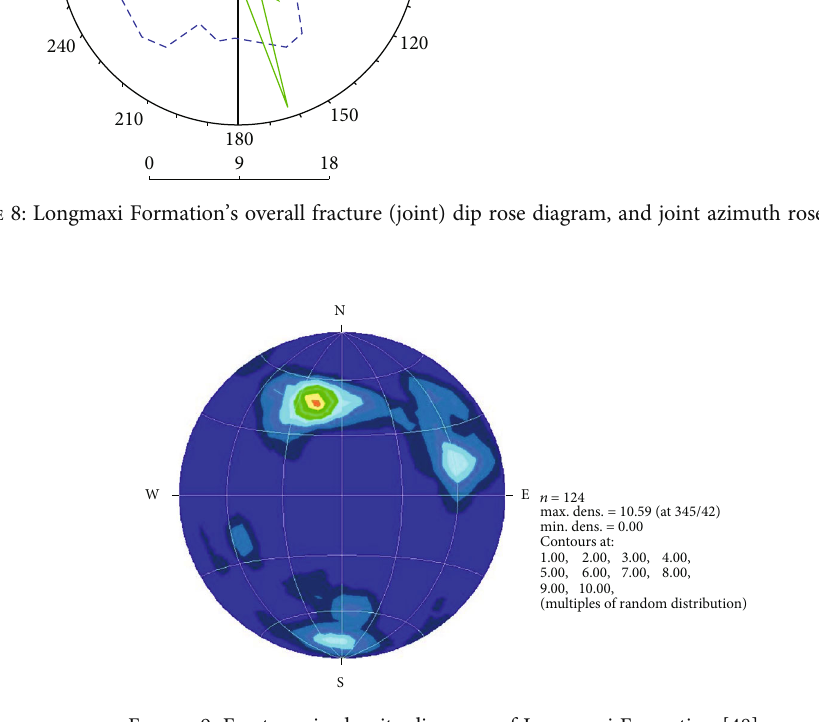
Figure 9: Fractures isodensity diagrams of Longmaxi Formation [48].